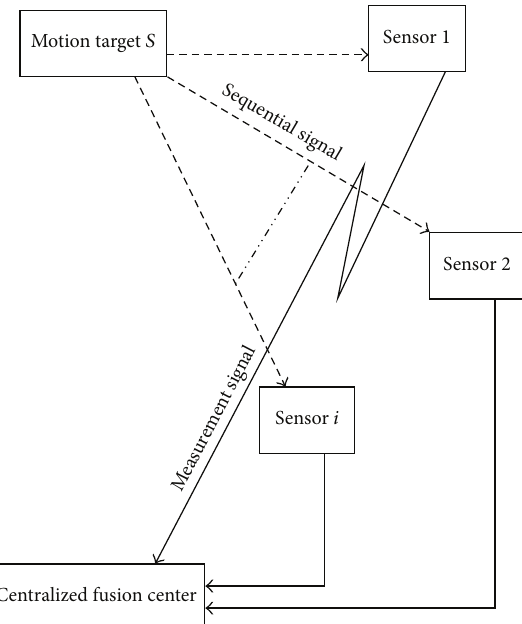
Figure 3: Diagram illustrating centralized